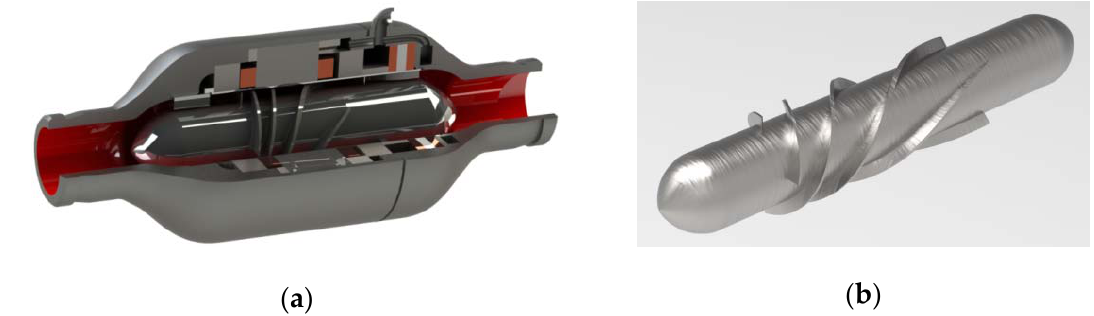
Figure 2. ( a ) Model of the conical spiral axial blood pump. ( b ) Photo of the impeller.